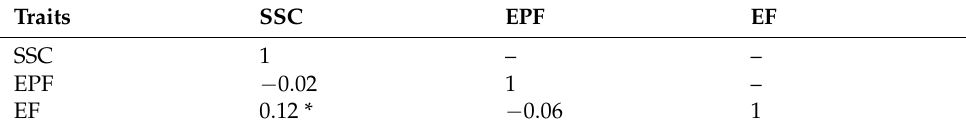
Table 3. Correlation analysis of fruit traits in the F 2 plant population. *, p < 0.05.